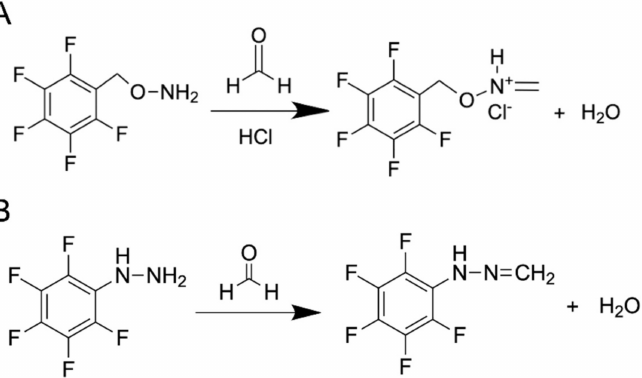
Figure 2. FA derivatization using PFBHA (O-(2,3,4,5,6-pentafluorobenzyl) hydroxylamine) ( A ) or PFPH (pentafluorophenylhydrazine) ( B